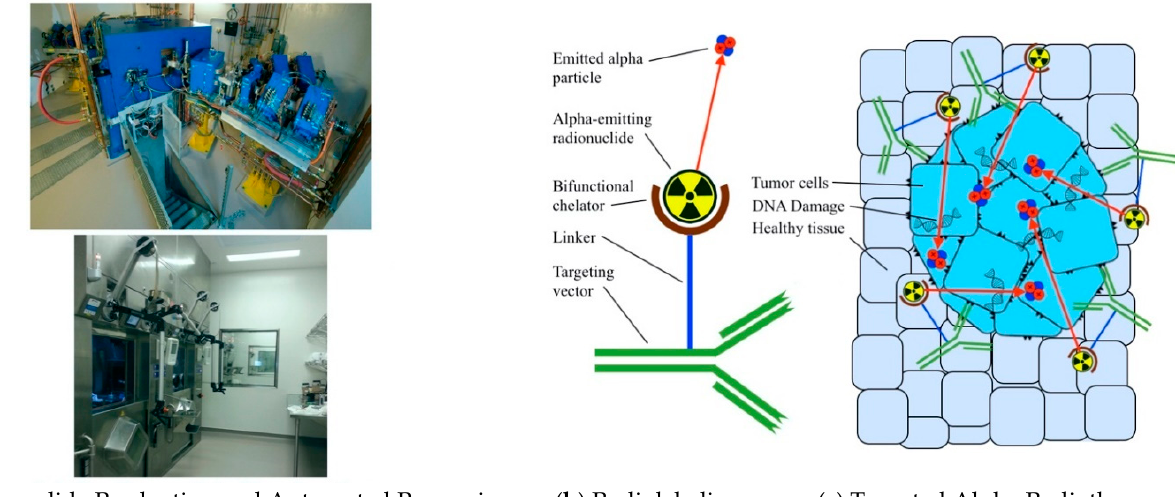
Figure 1. Key aspects of targeted alpha therapy: ( a ) radionuclide production via cyclotron, nuclear reactor or generator decay, and shielded automated processing; ( b ) radiolabeling the alpha-emitting radionuclide to a suitable targeting vector to form a bioconjugate; and ( c ) targeted alpha radiotherapy precisely destroys tumor cells while sparing surrounding healthy tissue.